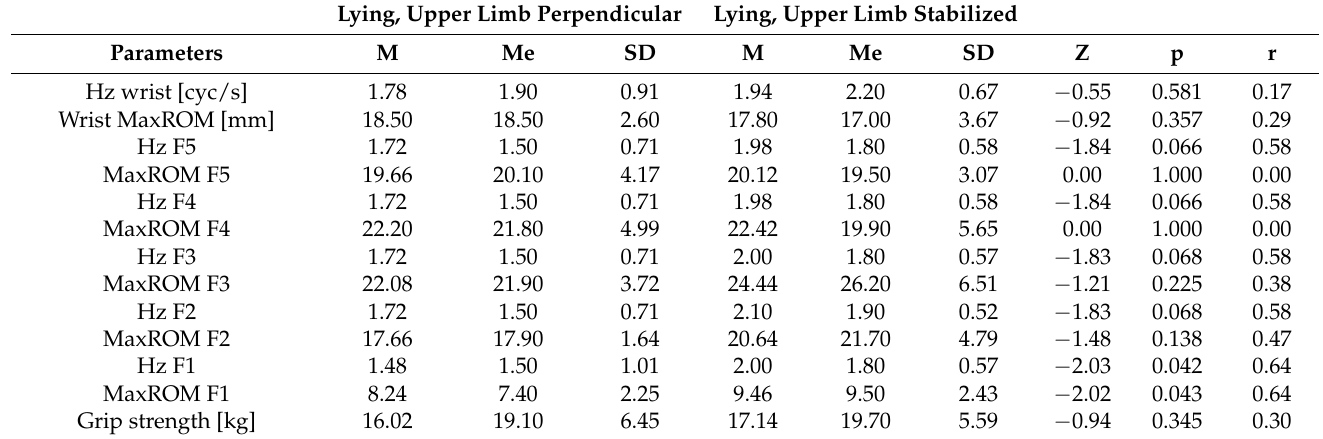
Table 10. Comparison of the movement and strength parameters in the lying positions with upper limb upwards and against the body in the group of patients after a cerebellar hemorrhagic stroke. Lying, Upper Limb Perpendicular Lying, Upper Limb